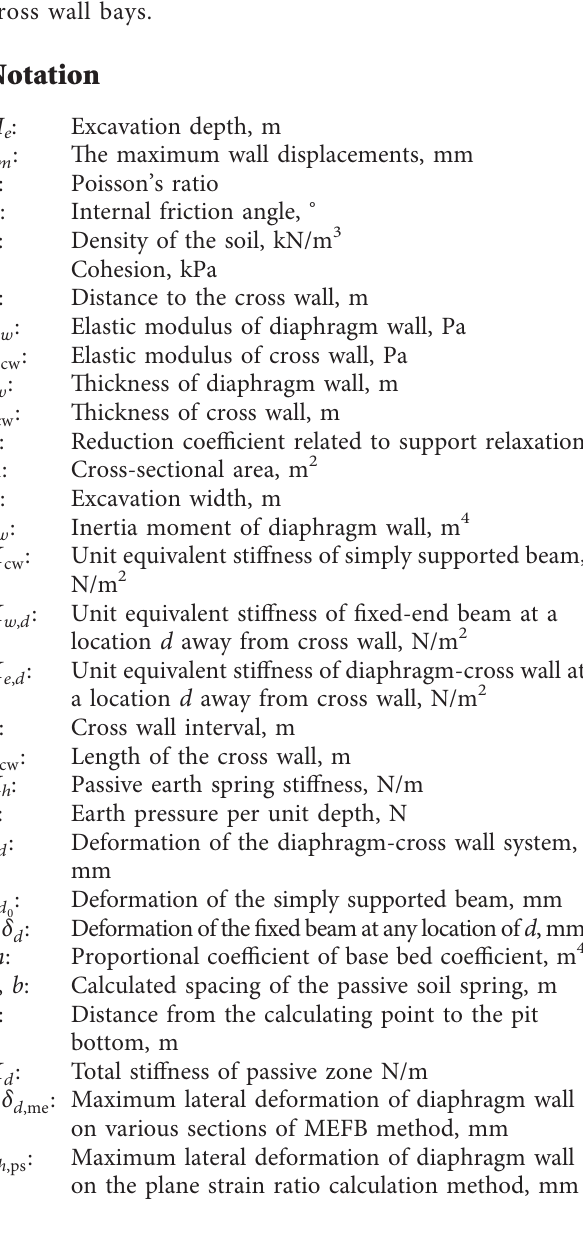
d and the cross wall em-